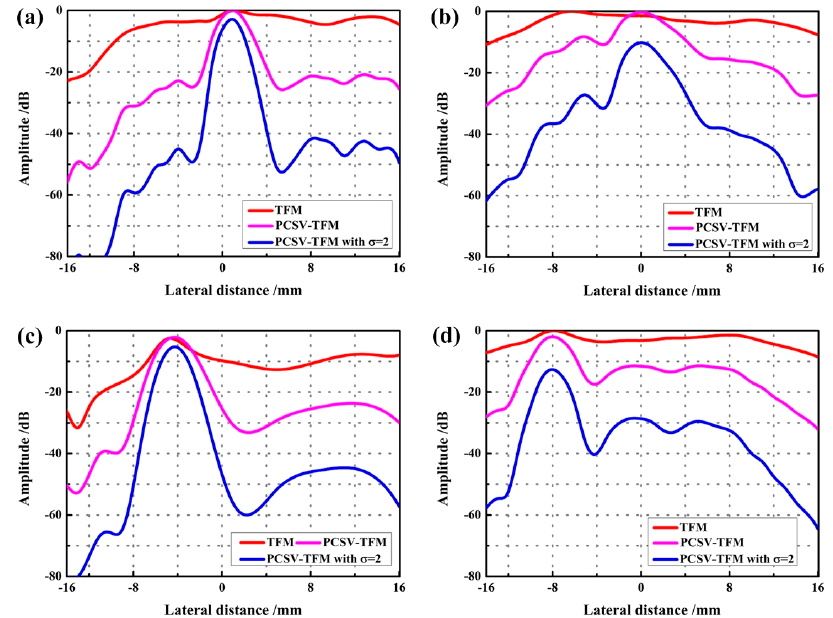
Figure 8. The lateral variations at the depth of ( a ) the fourth defect covered; ( b ) the fifth defect cov- ered; ( c ) the sixth defect covered; ( d ) the seventh defect covered; by using TFM, PCSV-TFM, and PCSV-TFM with power exponent σ = 2.